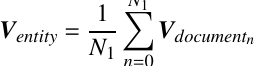
Fig. 1 Transformation of